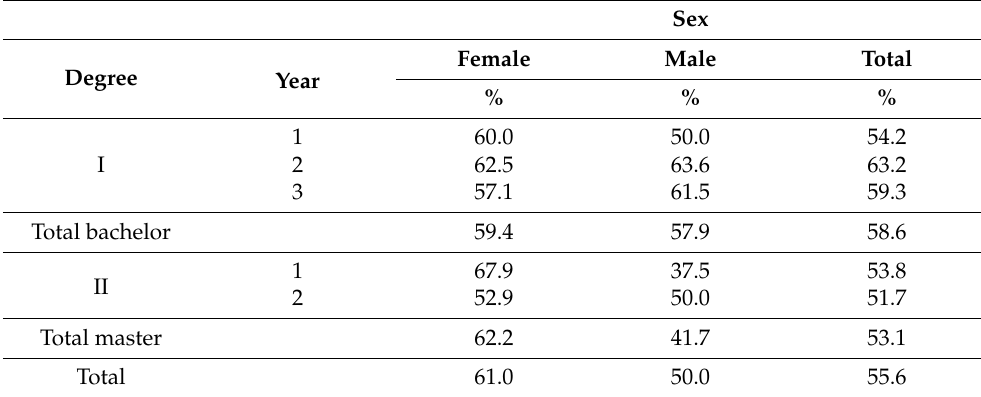
Table 1. Percentage of respondents by sex, degree and year of study (N =